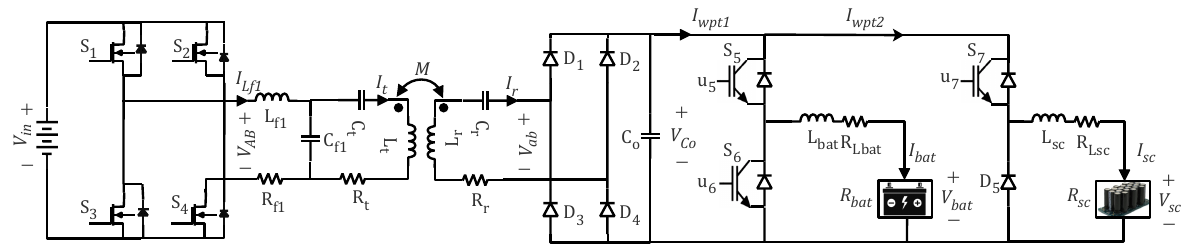
Figure 3. Circuit diagram of the proposed WPT–HESS system.